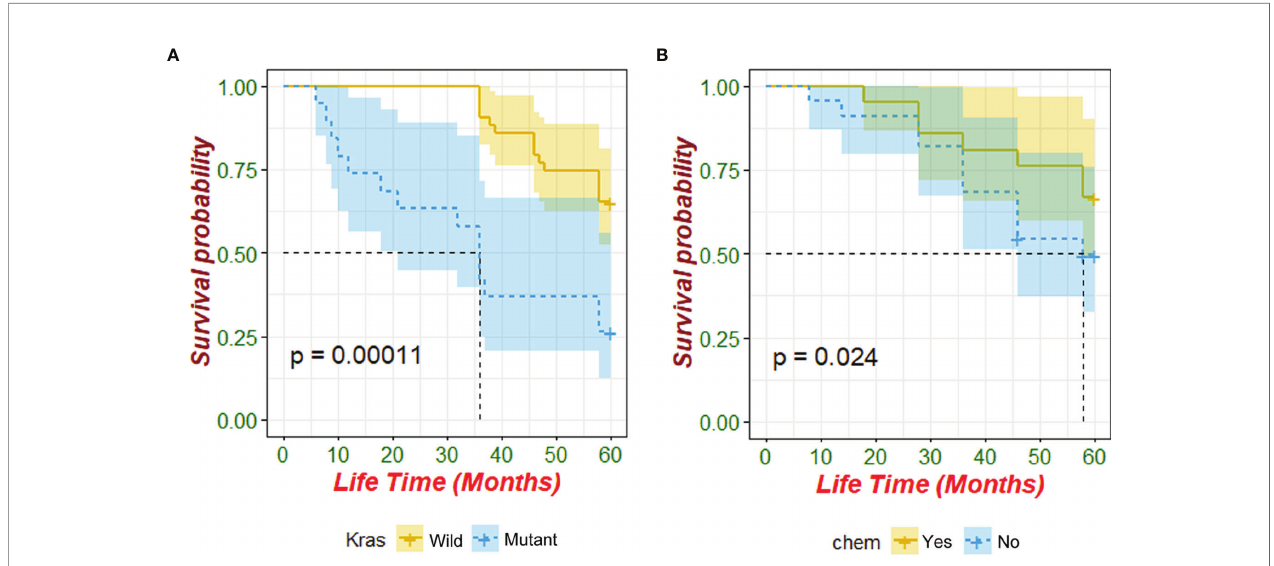
FIGURE 1 | Prognostic value of KRAS mutation and postoperative chemotherapy for patients with ECRC (chem: postoperative chemotherapy).